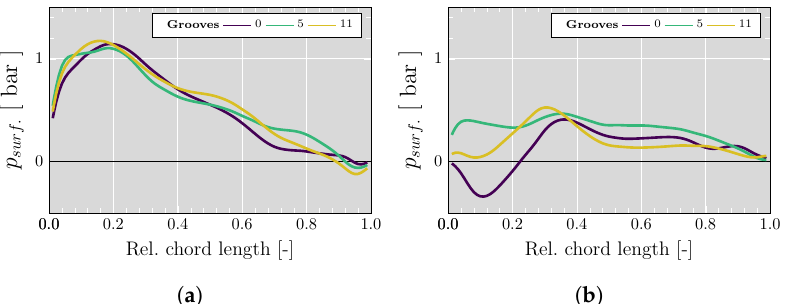
Figure 13. Rotor blade loading at 50% span with closed VGT position. ( a ) Lower speed and higher PR. ( b ) Higher speed and higher